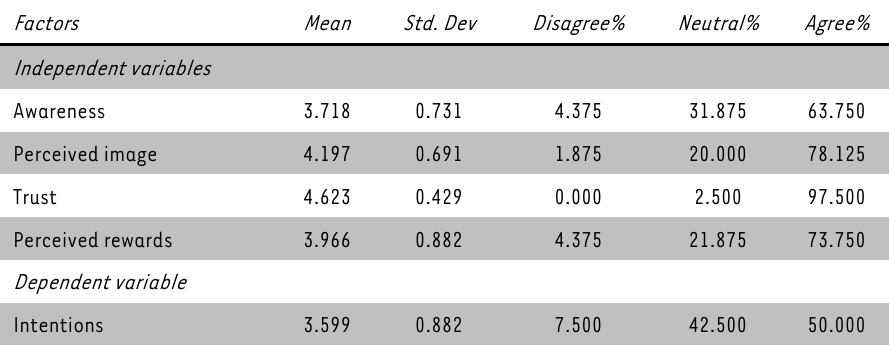
TABLE 5: Descriptive statistics on variables (N=160)